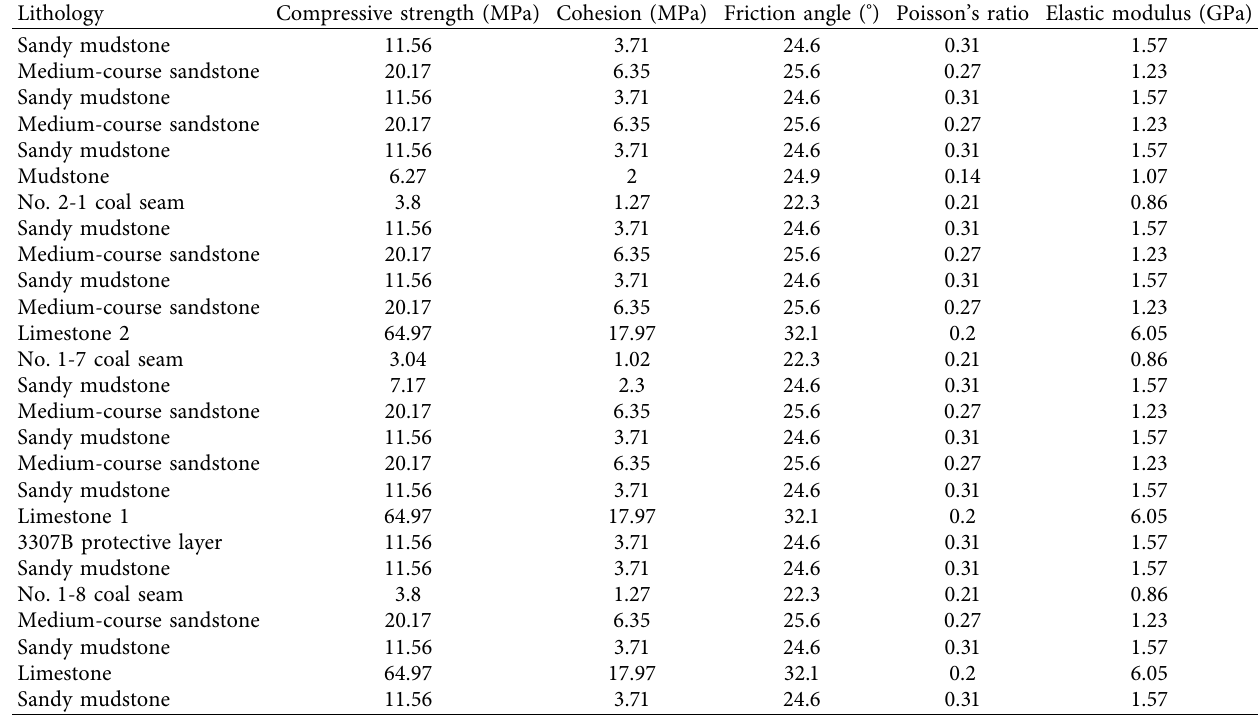
Table 1: Mechanical parameters for the prototype coal-rock seam.